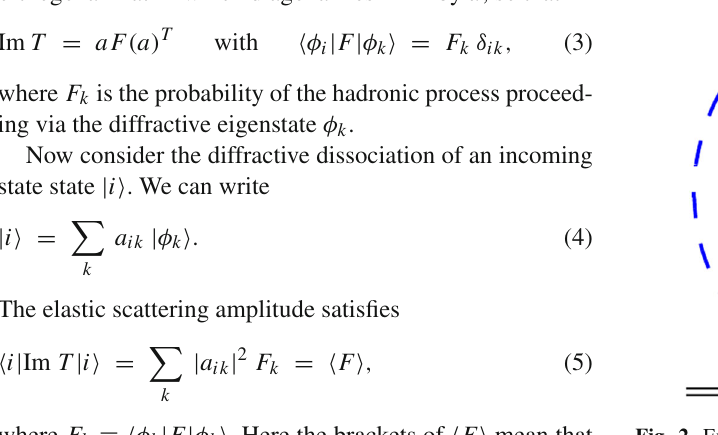
Fig. 2 Evolution of the wee parton density in rapidity (momentum fraction) space. The last step of evolution is shown by thick (blue) lines. The dashed curves indicate the eikonal-like absorptive corrections. n is the number of screening